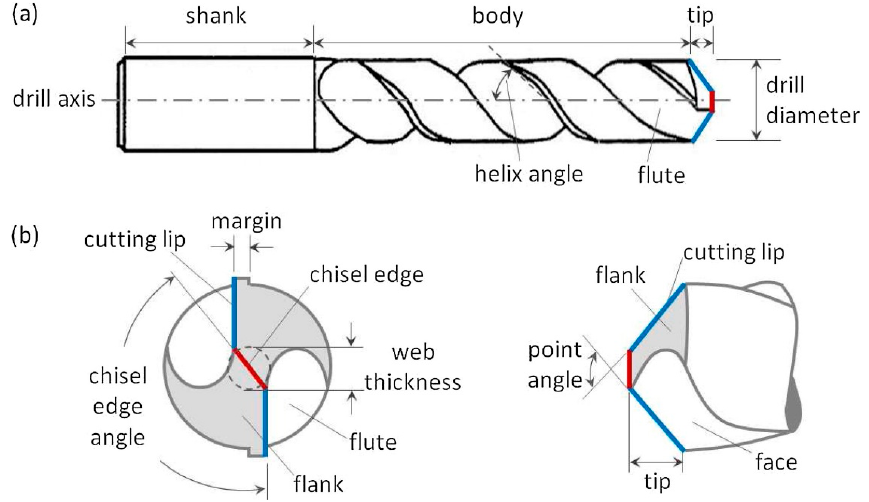
Figure 11. Surgical drill bit nomenclature: ( a ) twist drill bit; ( b ) axial view of drill bit tip [16].